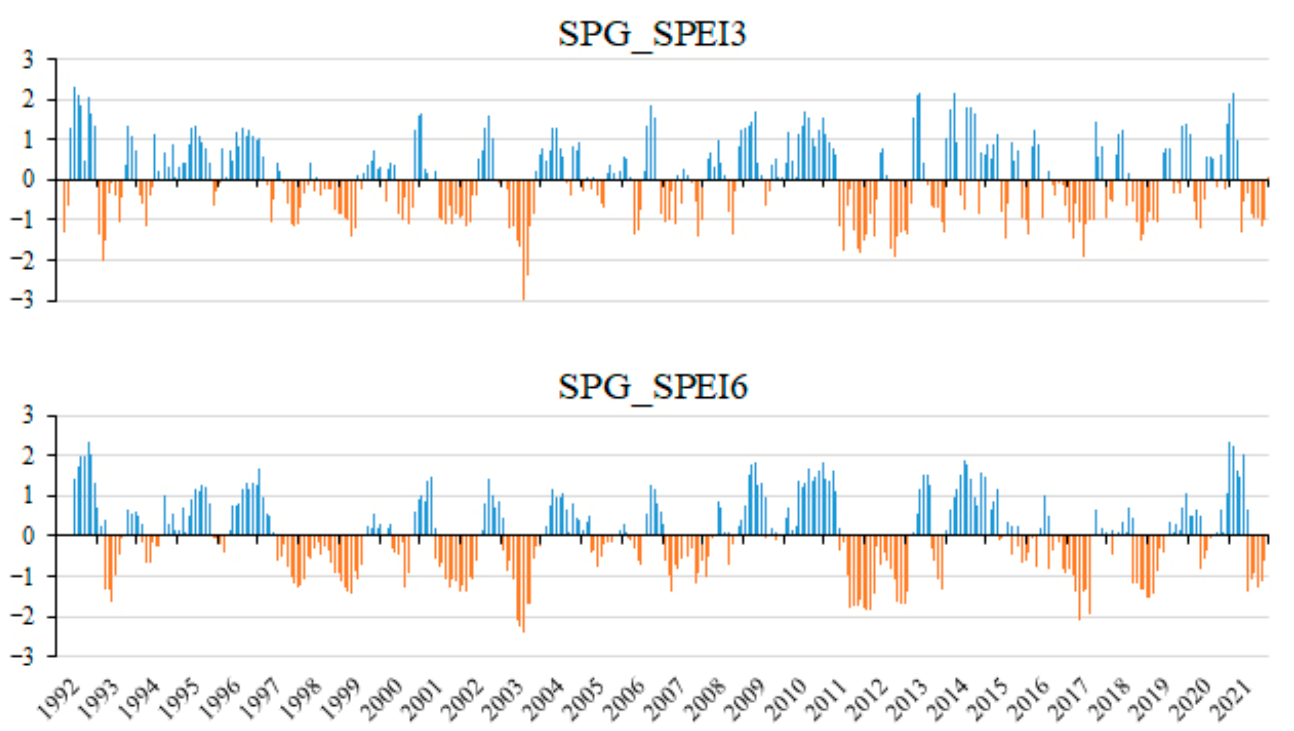
Figure 3. Long-term standardized precipitation-evapotranspiration index (SPEI) calculated at SPG on 3- and 6-month basis. For each year, blue and red bars represent, respectively, monthly positive and negative SPEI values.